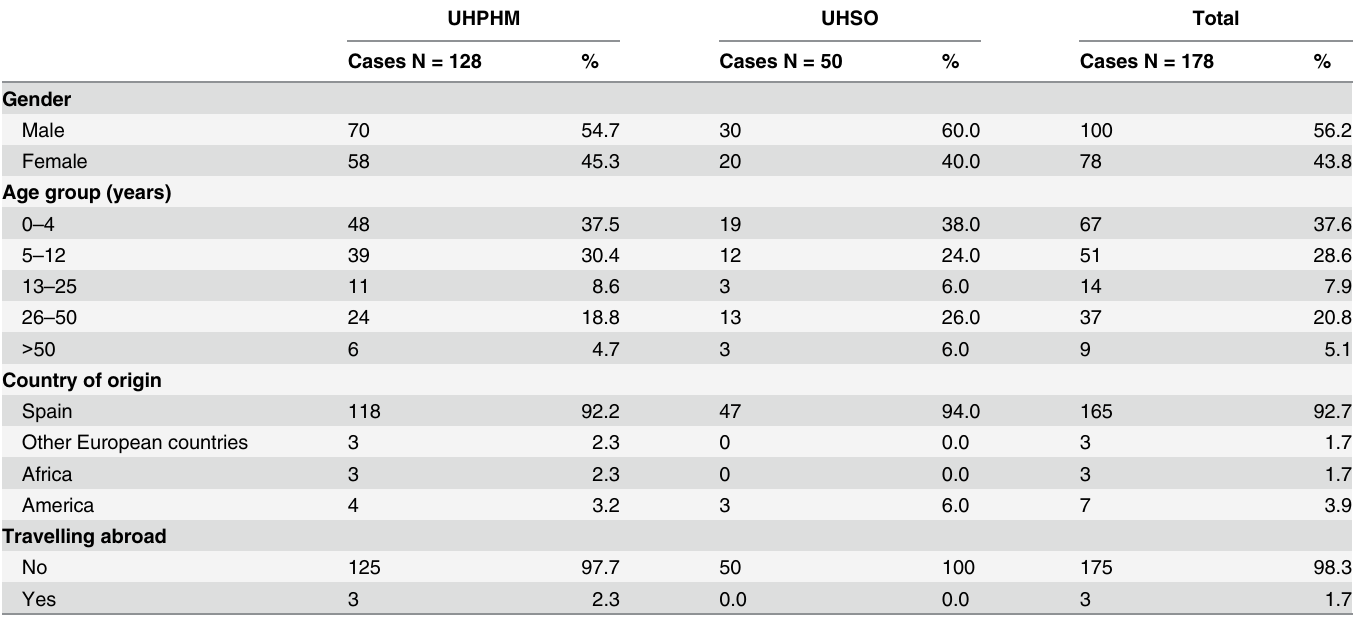
Table 1. Sociodemographic parameters in symptomatic patients with confirmed giardiasis attended at the University Hospitals Puerta de Hierro Majadahonda (UHPHM) and Severo Ochoa (UHSO), Madrid, December 2013 – January 2015.